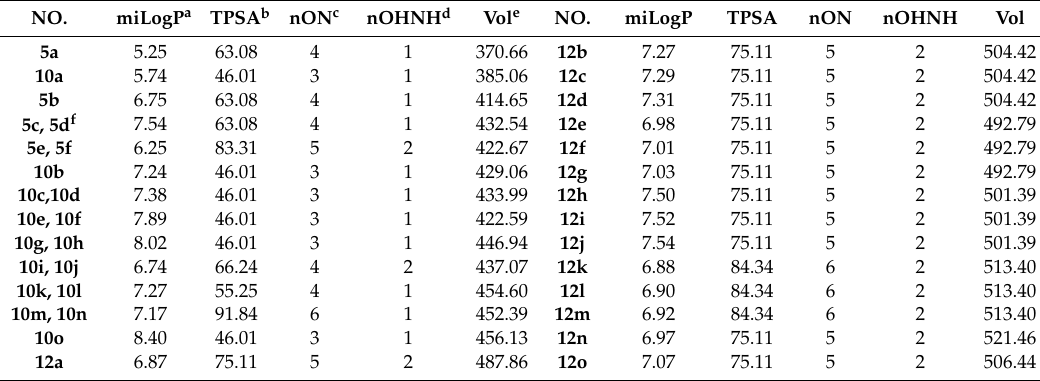
Table 3. Calculated molecular properties of all the derivatives.